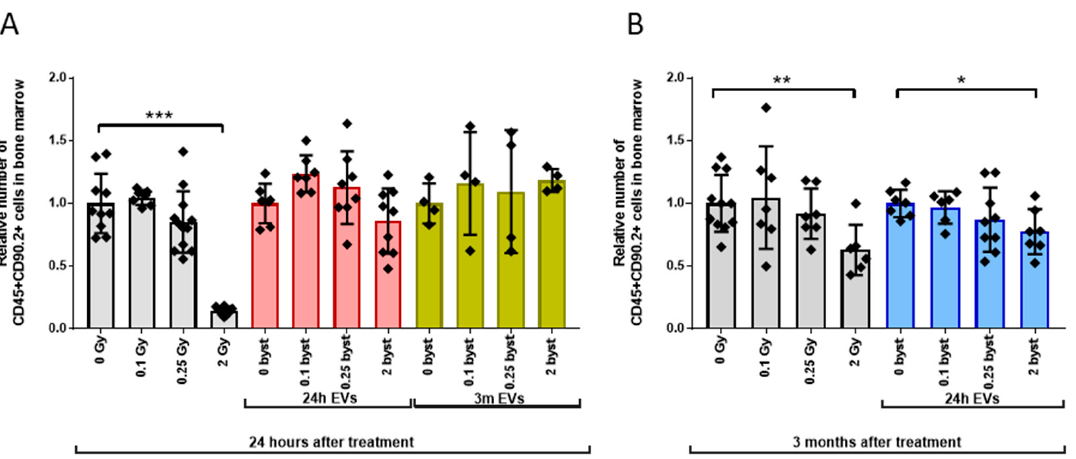
Figure 6. High Dose Irradiation Induces Persistent Depression of Lymphoid Progenitor Numbers, Extracellular Vesicle-Mediated Mild Bystander Effects Develop Late after Treatment. Irradiation, extracellular vesicle treatment and bone marrow cell phenotyping was carried out as described in the Materials and methods section. CD45+CD90.2+ cells were considered lymphoid progenitors. ( A ) Relative changes in lymphoid progenitor numbers were evaluated 24 h after treatment. Grey bars represent total-body irradiated mice; red bars represent mice treated with bone marrow-derived extracellular vesicles isolated from mice 24 h after irradiation; yellow bars represent mice treated with bone marrow-derived extracellular vesicles isolated from mice 3 months after irradiation. ( B ) Relative changes in lymphoid progenitor numbers were evaluated 3 months after treatment. Grey bars represent total-body irradiated mice; blue bars represent mice treated with bone marrow-de- rived extracellular vesicles isolated from mice 24 h after irradiation Bars represent mean values of